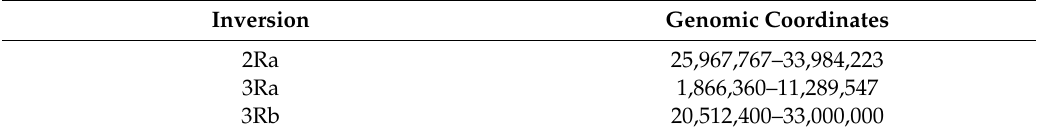
Table 1. Approximate genomic coordinates of inversion